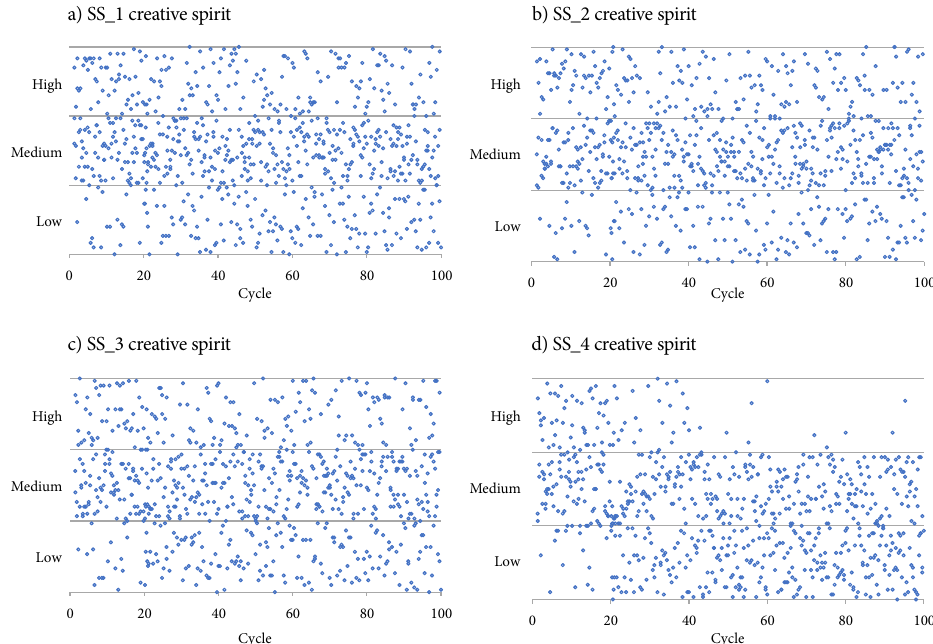
Figure 7. Evolution of entrepreneurs’ innovative spirit in different social capital